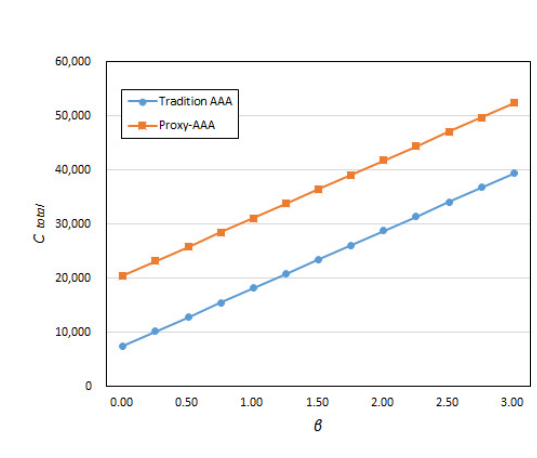
Figure 14. Figure 13 Total overhead ( p = 30 , (cid:21) = 1